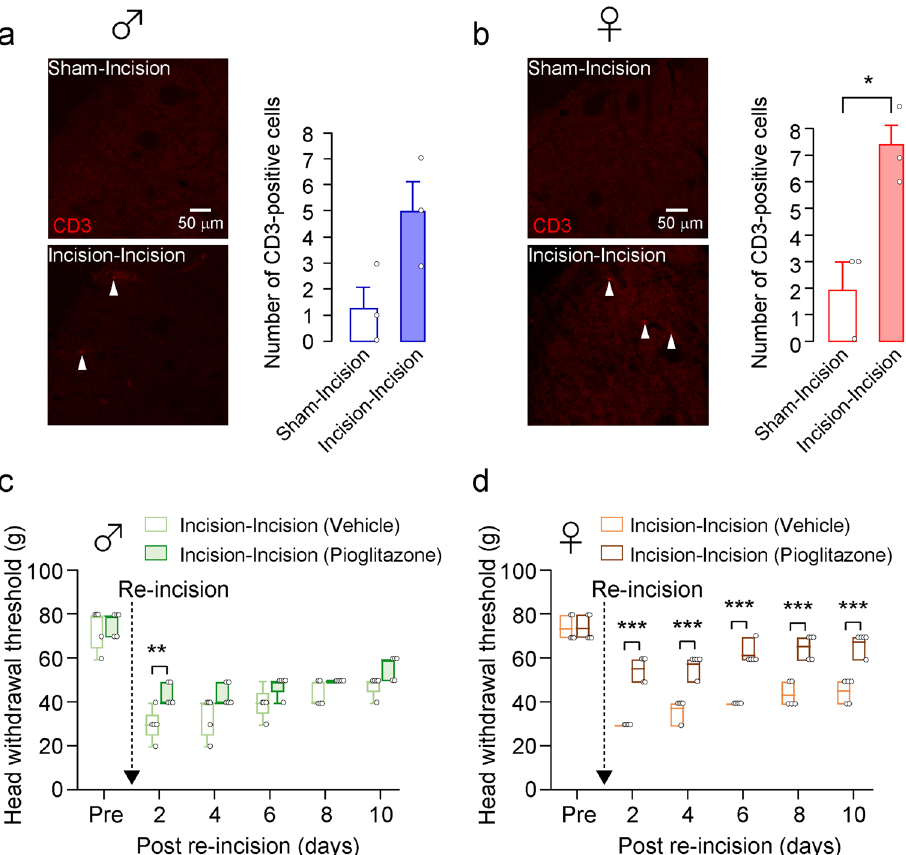
Figure 3. Infiltration of T cells in the Vc and the effects of pioglitazone on HWT after whisker pad skin re-incision in male and female rats. ( a, b ) The images showing CD3-positive cells in the Vc of male ( a ) and female rats ( b ) 10 days after whisker pad skin re-incision. Scale bars = 50 µm. The columns represent the mean number of CD3-positive cells in the Vc 10 days after whisker pad skin re-incision. Arrowheads indicate CD3- positive cells. Data represent the mean ± SEM. n = 5 in each, unpaired t-test, * p = 0.0161 in ( b ). ( c, d ) Time course of HWT of male rats ( c ) and female rats ( d ) after whisker pad skin re-incision. Vehicle and pioglitazone were continuously delivered in the cisterna magna by an osmotic pump before whisker pad skin re-incision. Broken arrows indicate that the whisker pad underwent skin re-incision at 7 weeks of age. “Pre” indicate the day before skin incision. Boxes show the 25–75th percentiles with the median value indicated as a line within each box. Whiskers indicate the 10th and 90th percentiles of the data. n = 5 rats in each, GEE method post hoc Bonferroni’s test (** p = 0.004 in ( c ), *** p < 0.001 in ( d ), Vehicle vs.